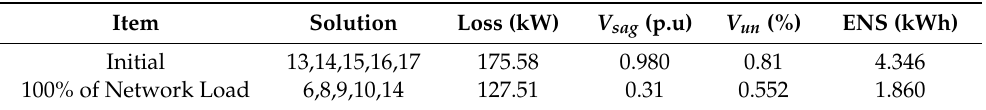
Table 7. The results of many-criteria reconfiguration of an unbalanced 13-bus network (100% of network